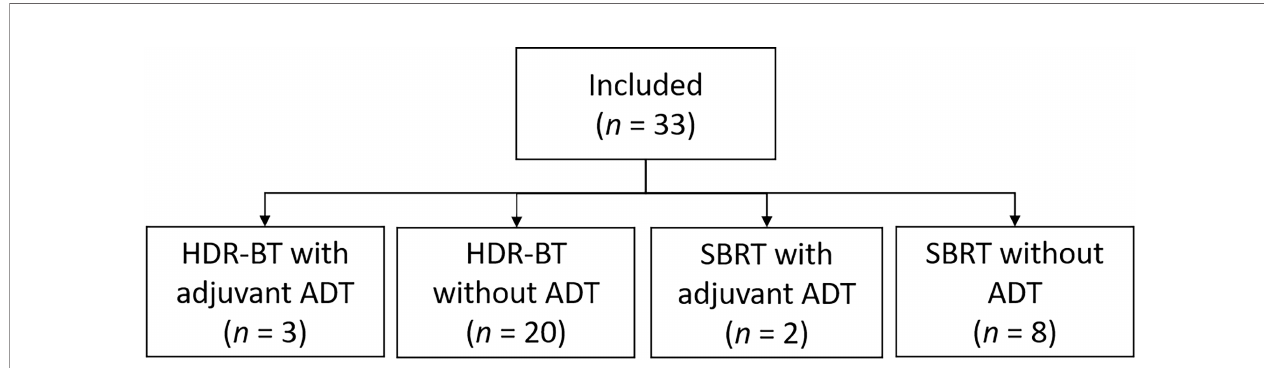
FIGURE 1 | Overview of the salvage treatment. HDR-BT, high dose-rate brachytherapy; ADT, androgen deprivation therapy; SBRT, stereotactic body radiotherapy.